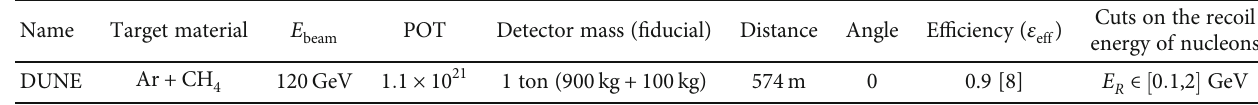
Table 1: Essential parameters for DUNE near